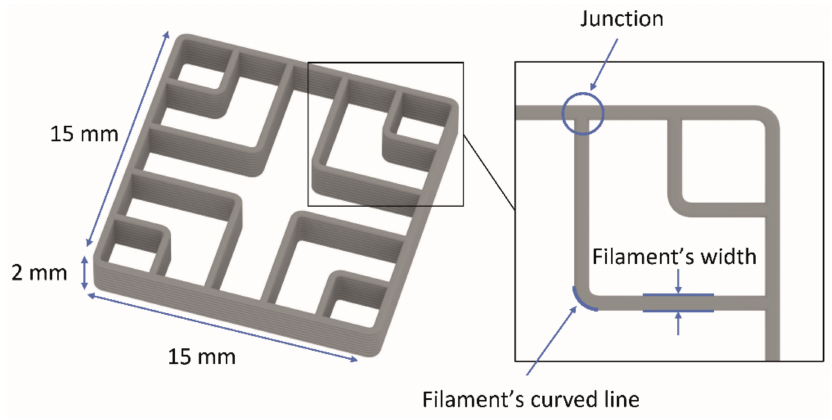
Figure 1. Scheme of 3D printed test